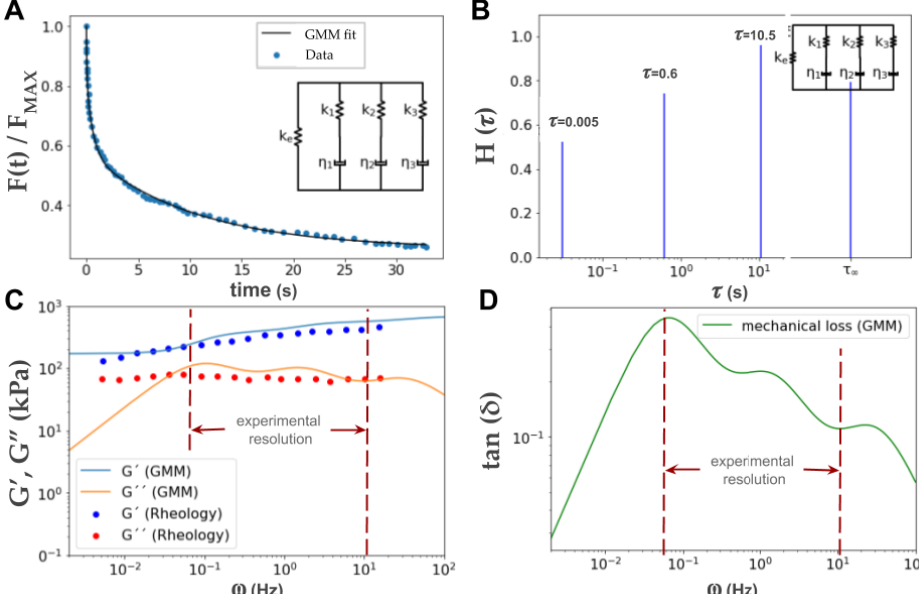
Figure C1. GMM analysis of published experimental data (FT curve) obtained by nanoindentation-relaxation of a biolog- ical cell using AFM [61] and comparison of computed frequency behavior with experimental data of dynamic moduli. The